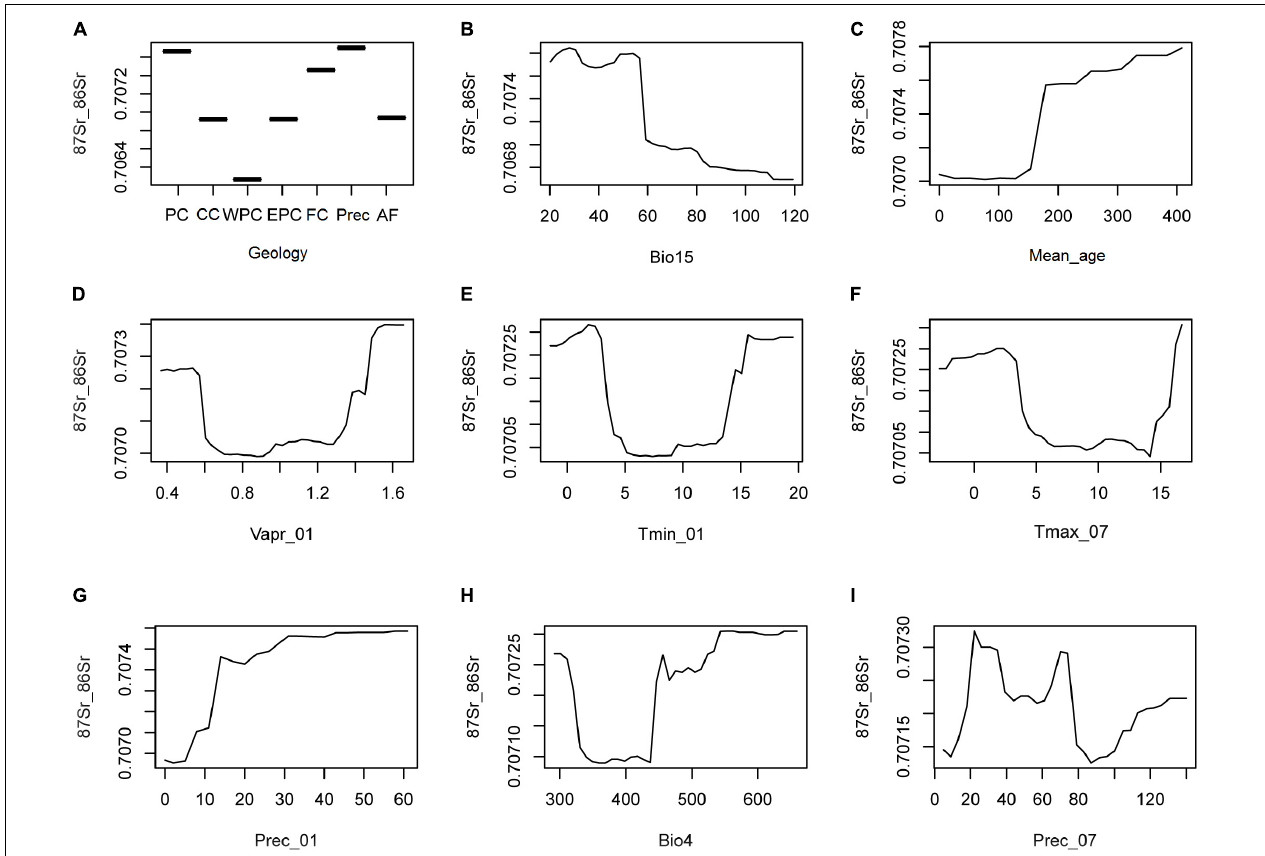
FIGURE 6 | Analysis of partial dependence between the variables of the Random Forest models and 87 Sr/ 86 Sr values for the “Plants + Rodents” model. Key: (A) geological province, (B) temperature seasonality, (C) mean rock age (years), (D) evapotranspiration January, (E) minimum temperature January, (F) maximum temperature July, (G) precipitations January, (H) precipitation seasonality, and (I) precipitation July.